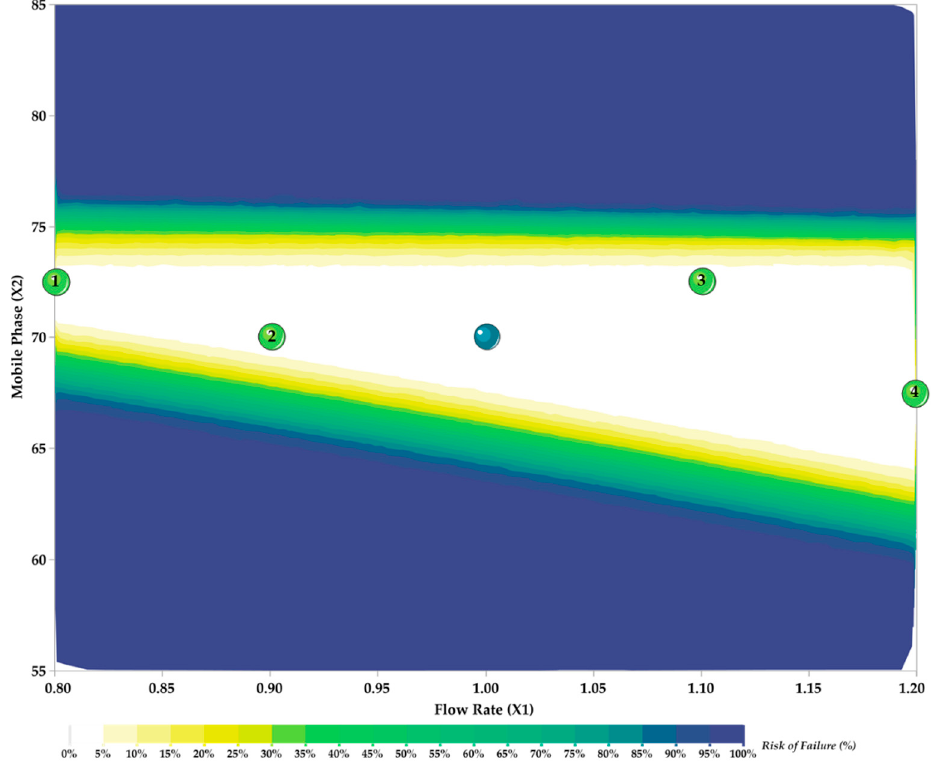
Figure 9. Method Operating Design Region (MODR) definition for the simultaneous determination of DSF and Cu(DDC) 2 , according to the face-centered central composite design (FcCCD) conditions. In order to validate the predictability of the operable region, four random conditions Table 5. MODR definition criteria and experimental (Figure 9, green dots) were experimentally evaluated and compared to the predicted CAA responses by the models (Table 5). For these levels, the MODR also complies with the ATP (Table 1), supporting the good predictability of the models. For convenience, the chosen method parameters to proceed for formal validation were set as being 70:30 ( v / v ) ACN:H 2 O, at a flow rate of 1.0 mL/min (Figure 9, blue dot). These conditions guarantee